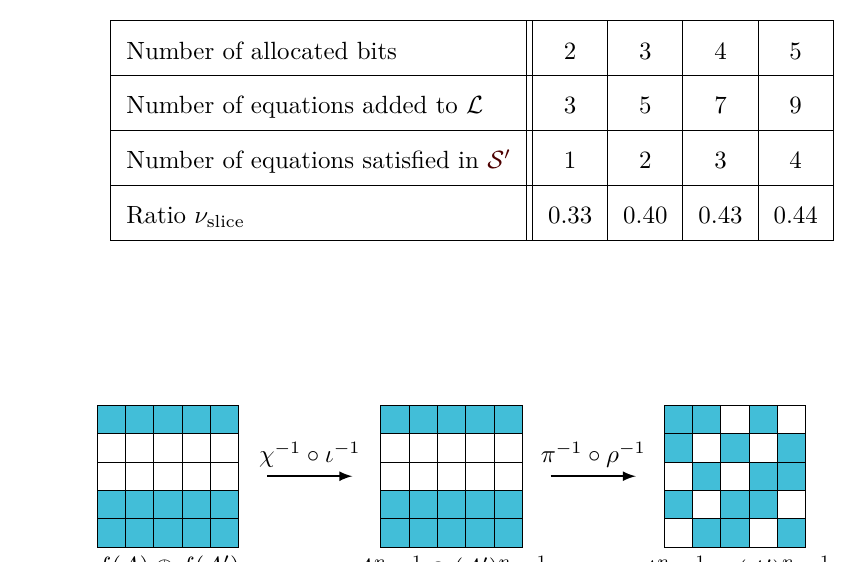
Table 3: Different choices for the number of bits per slice to fix. (outer state made of two planes)